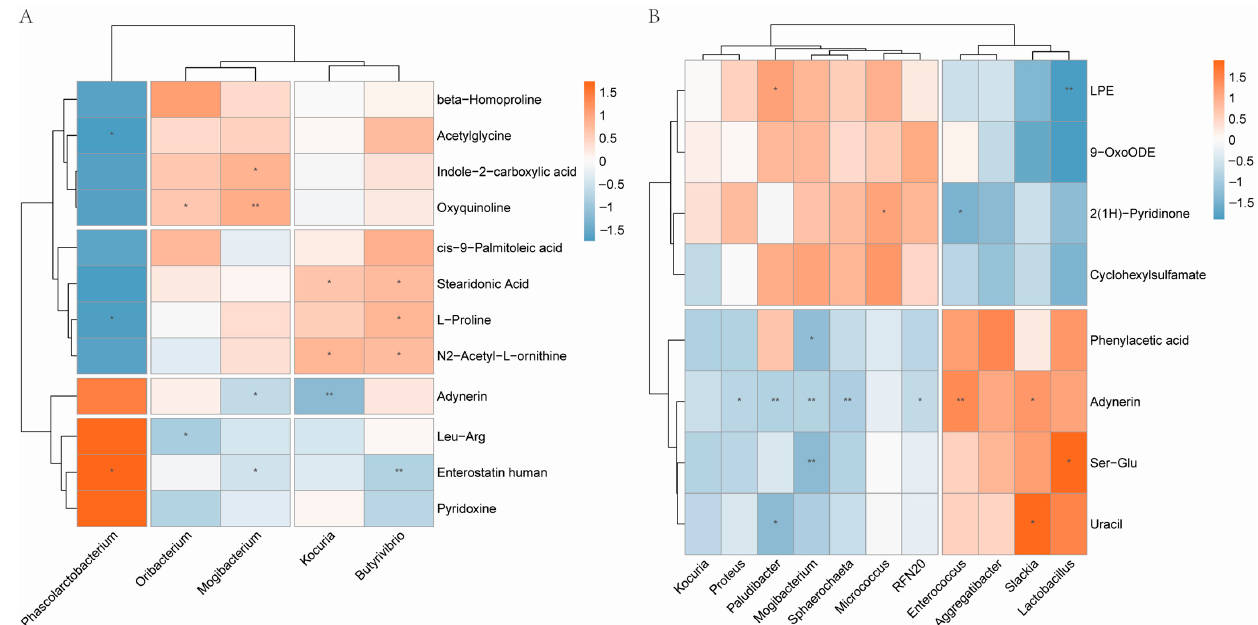
Figure 5. Hierarchical clustering heat map between T2DM and Control groups ( A ), IGR and Control groups ( B ). * p < 0.05 and ** p < 0.01. The X axis represented the significantly different microbiotas and the Y axis represented the significantly different metabolites. Red, positive correlation; blue, negative correlation.